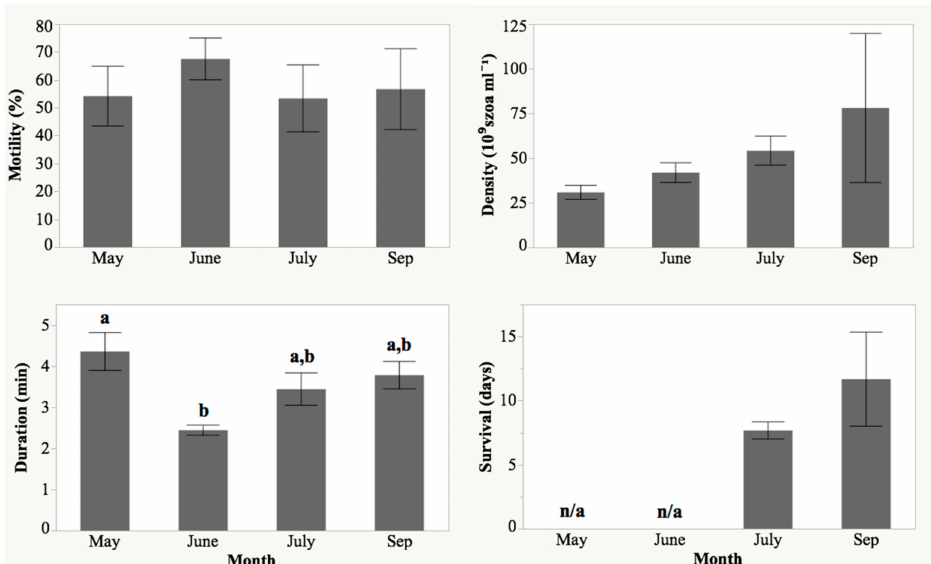
Figure 4. Mean ( ± SEM) sperm quality parameters of F1 greater amberjack at different times during the reproductive season (spermatozoa (szoa) forward motility, density, duration of motility and maximum survival during storage at 4 ◦ C). Statistically significant differences among sampling times are indicated by different lower-case letters (a, b) ( p ≤ 0.05). n/a = not